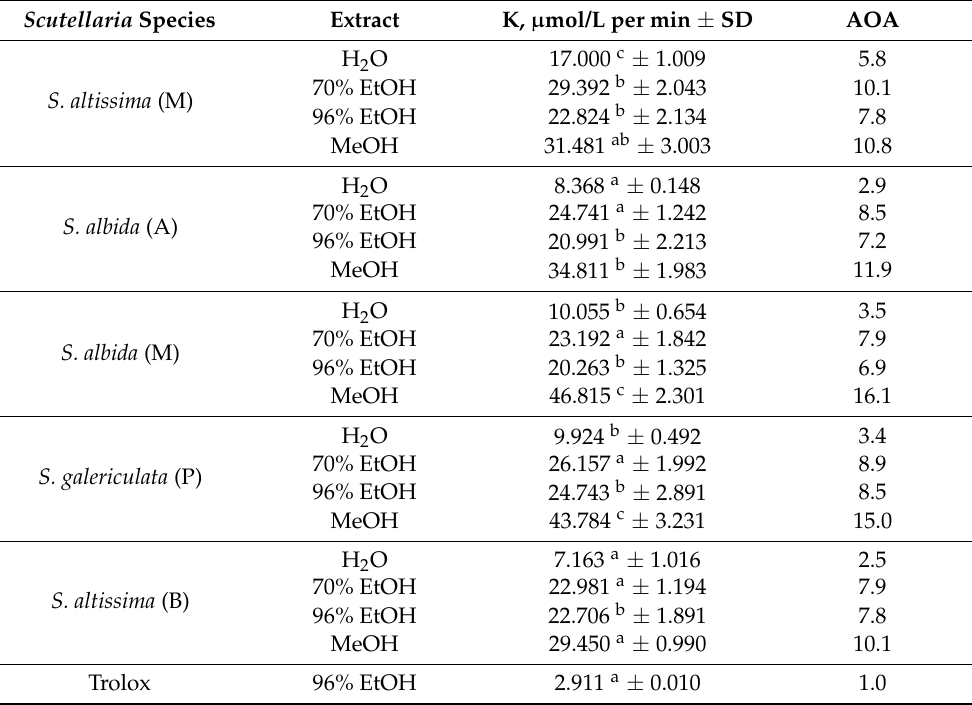
Table 5. Antioxidant Activity (AOA) of Extracts from Scutellaria Species, as Measured by Electro- chemical